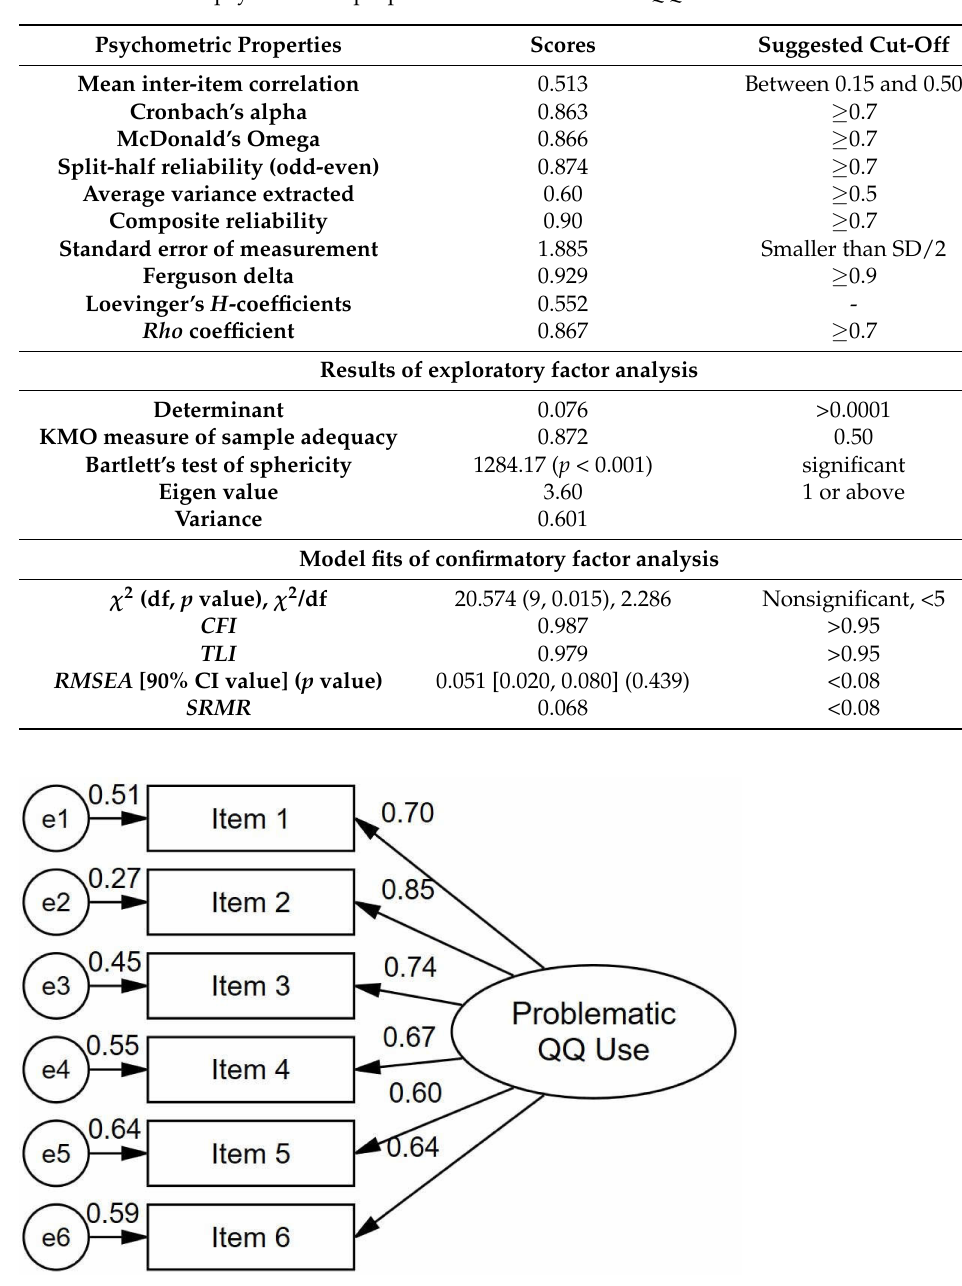
Figure 1. Factor structure and standardized loadings of the six items in the Problematic QQ Use